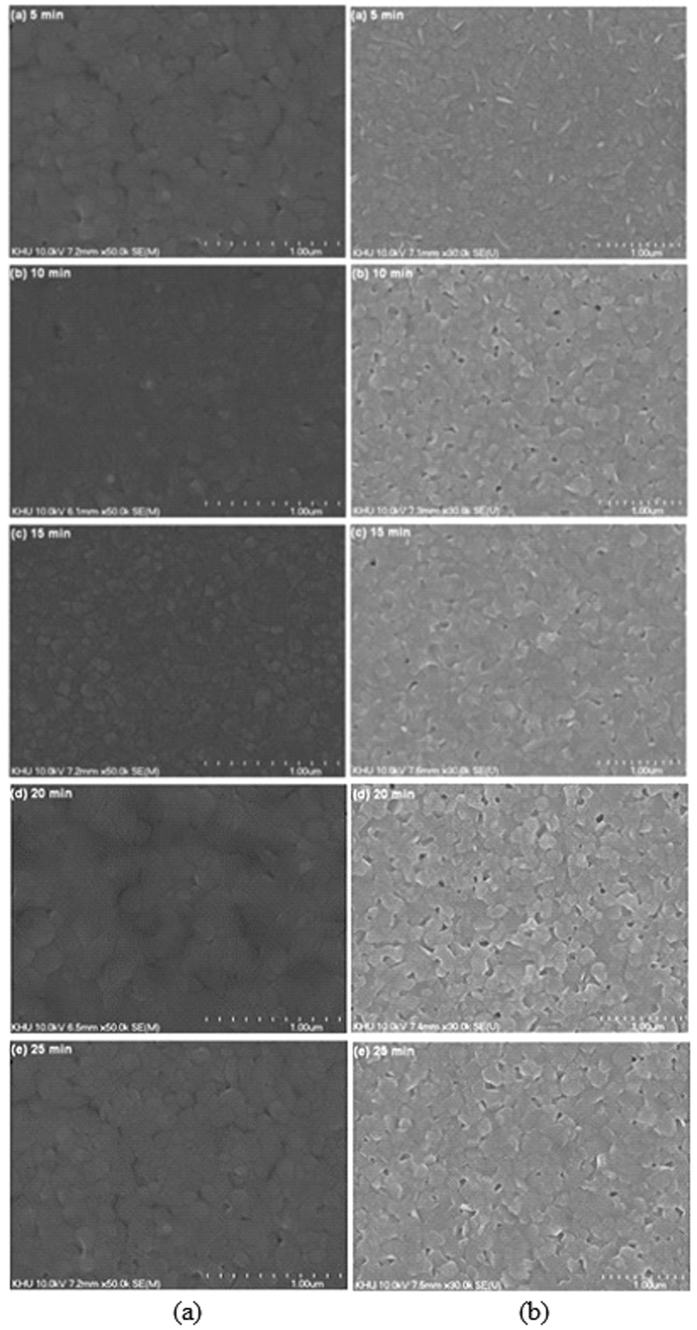
SEM images of MAxFA1−xPbI3 films with (a) 10, and (b) 400 sccm H2 flow rates with growth time increasing from 5 to 25 min.